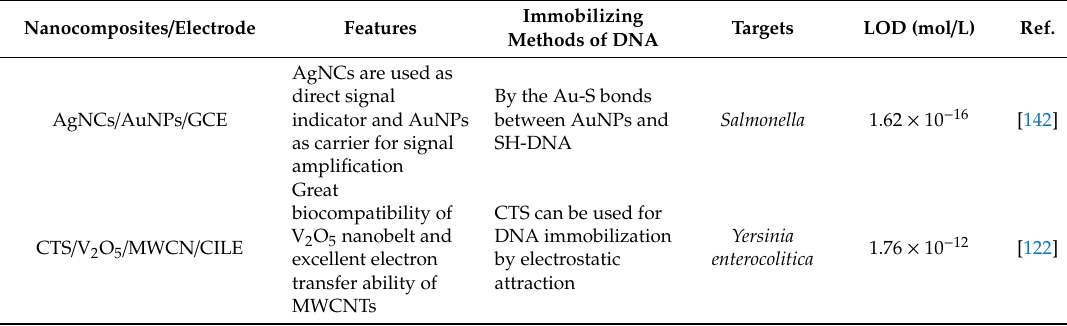
Table 6. Nanocomposites-basedelectrochemicalDNAbiosensorsforfoodbornebacterialpathogendetections. Nanocomposites /